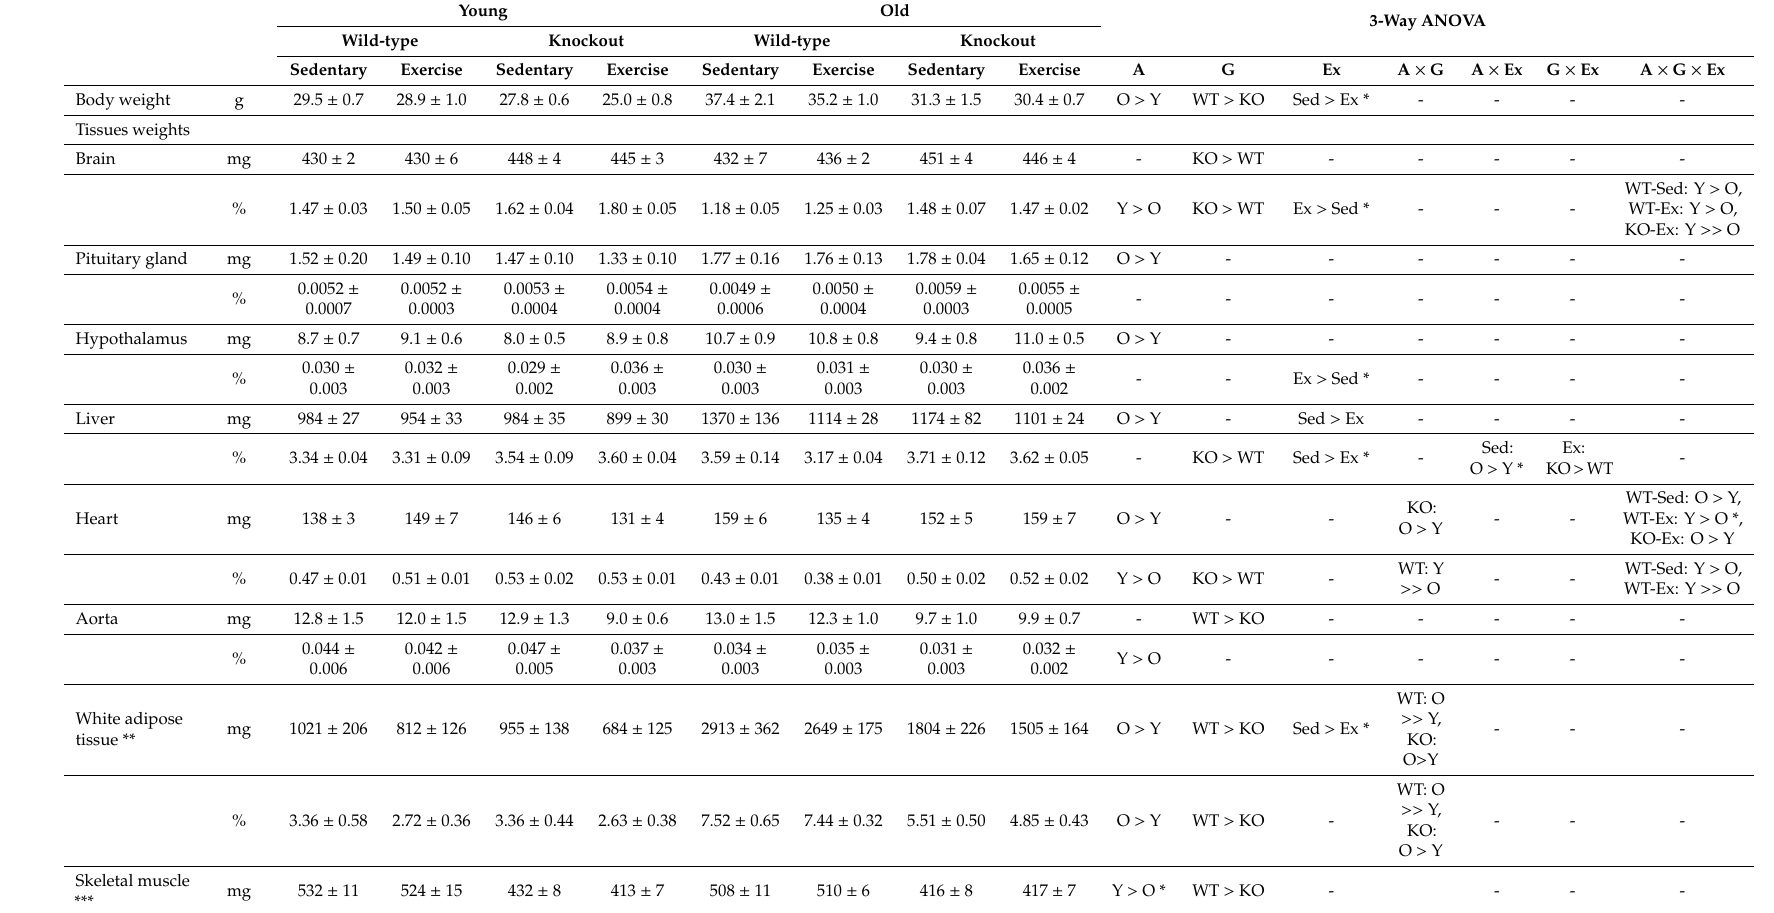
Table 3. Body and tissue